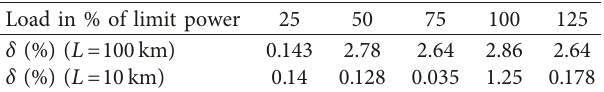
Table 9: Influence of the different electrical load values and dif- ferent distances to the fault on the error of the average fault location result.